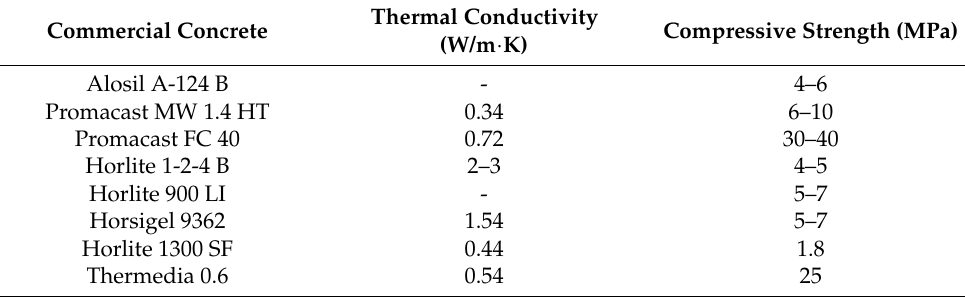
Table 2. Thermal conductivity of commercial